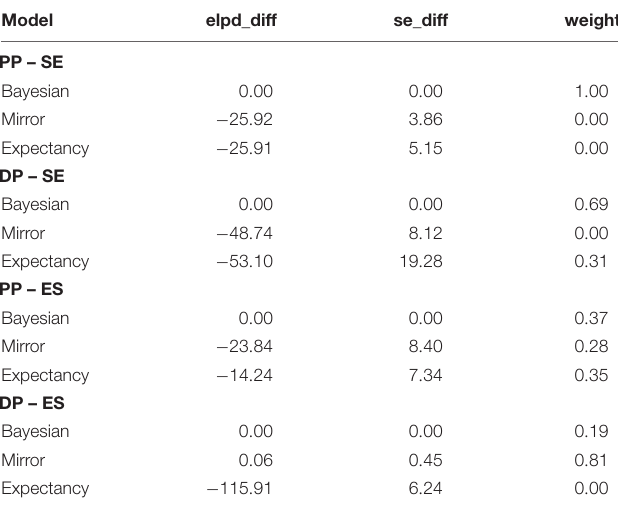
TABLE 19 | Difference in expected log-predictive density (elpd_diff) of the models assessed for four subsets of the data from Experiment 2, depending whether the verb is stimulus–experiencer (SE) or experiencer–stimulus (ES), and whether the pronoun shown is personal (PP) or demonstrative